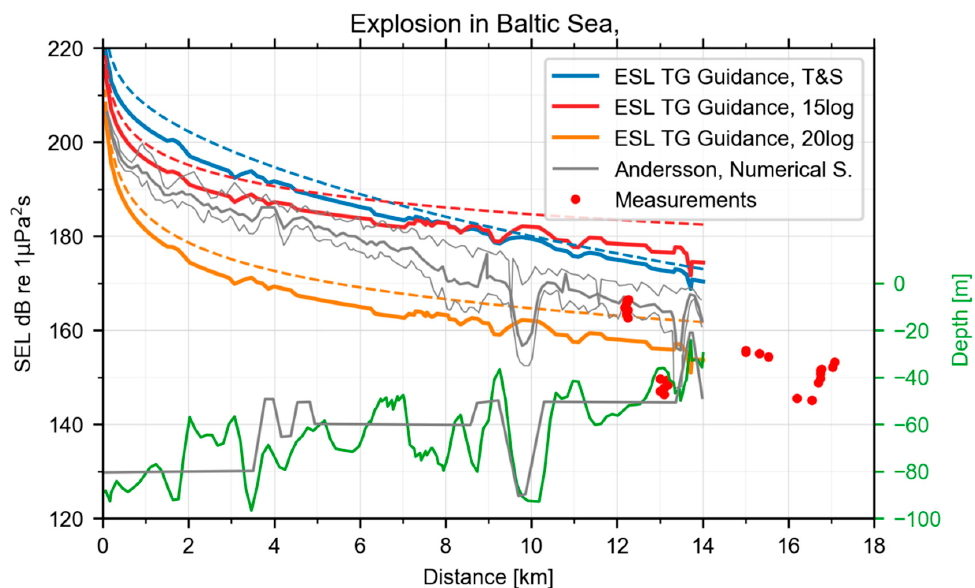
Figure 9. Modelled SEL versus distance to the explosion source location in the direction of measurement locations taking the bathymetry (via the cut-off frequency) into account (solid lines) and neglecting bathymetry (dashed lines). The different colours refer to the propagation formula used to determine the SEL according to the labels. The water depth used in this study from georeferenced data used to calculate the cut-off frequency for the propagation estimates illustrated by the solid lines is shown in green. Results of numerical calculations presented with data from Andersson [16] including the water depth are shown in grey, where the thin grey lines depict the spread of the transmission loss predictions.